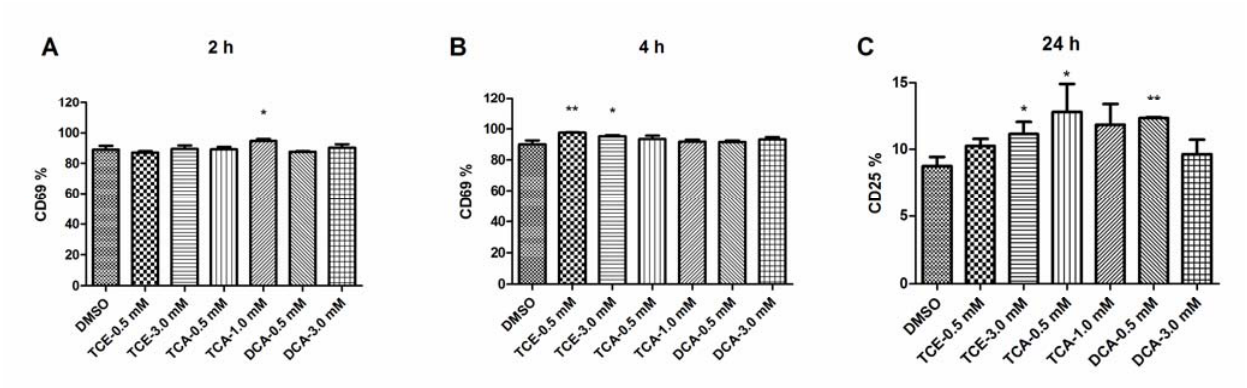
Figure 3. Effect of TCE, TCA and DCA on CD25 and CD69 expression levels in Jurkat cells. Cells were pretreated with TCE (0.5 and 3.0 mM), TCA (0.5 and 1.0 mM) and DCA (0.5 and 3.0 mM) for 16h and then stimulated with PMA (50ng/mL) and Ion (1mM) for 2 h, 4 h and 24 h. Jurkat cells were isolated and labeled with anti-human CD25 PE and CD69 APC antibodies. CD25 and CD69 expressions were analyzed by flow cytometry. Graphical representation of CD69-positive cells by flow cytometry after PMA/Ion stimulation for 2 h ( A ) and 4 h ( B ) and graphical representation of CD25-positive cells by flow cytometry after PMA/Ion stimulation for 24h ( C ). The bars represent the mean ± SD of three independent experiments. * p < 0.05, ** p < 0.01 compared to the DMSO vehicle control group.